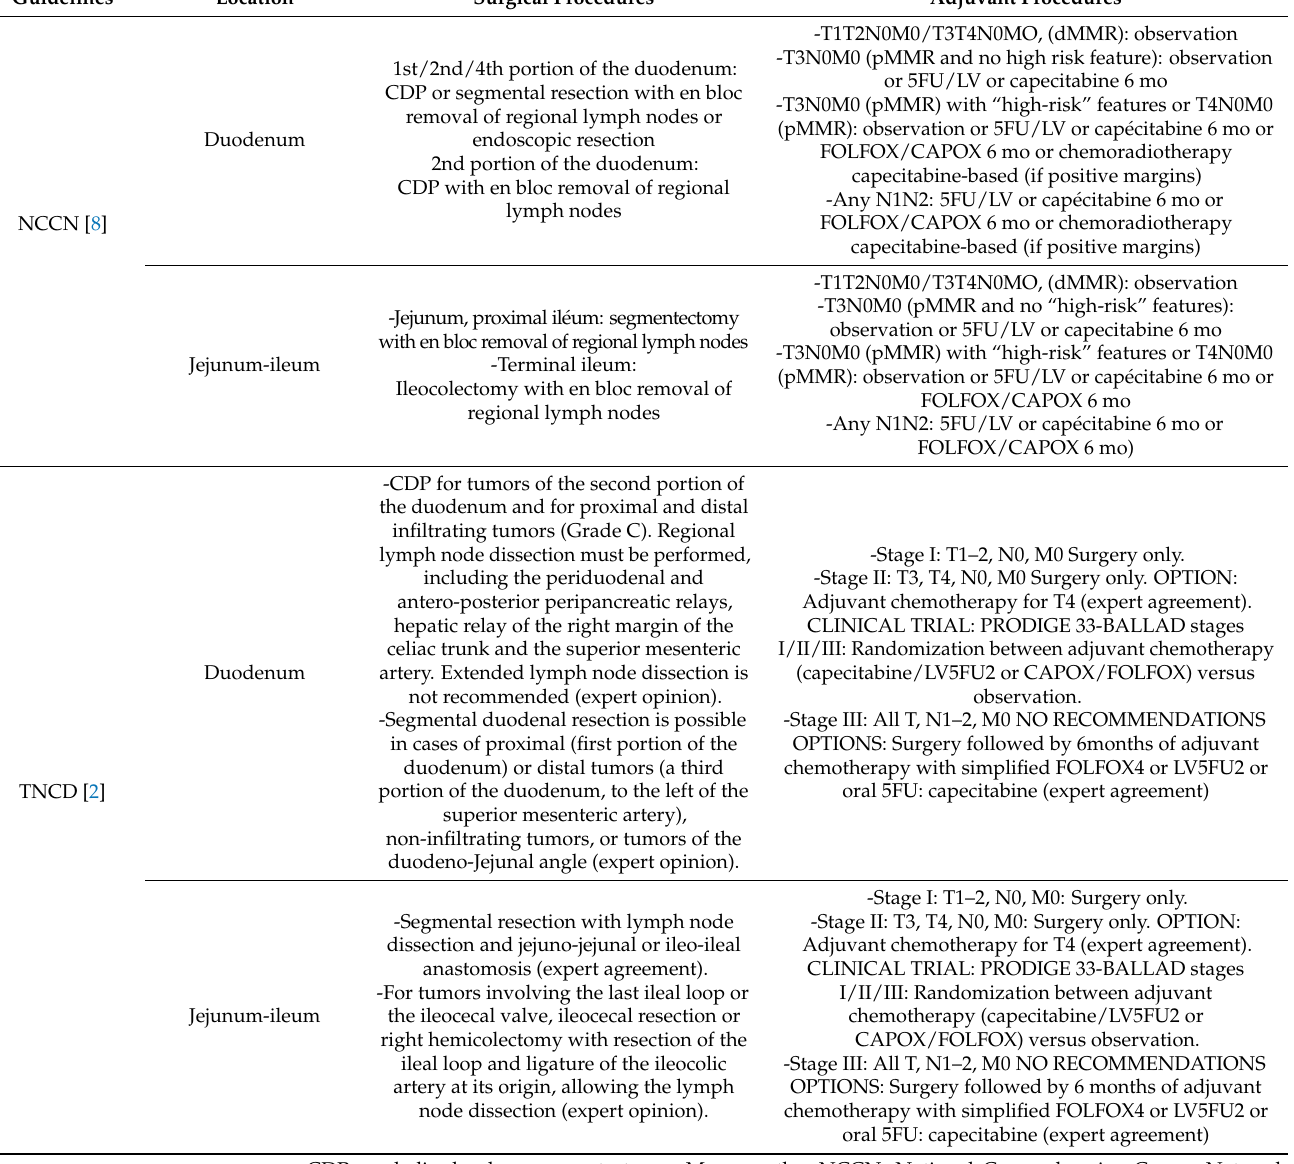
Table 4. Summary of international guidelines for localized small bowel adenocarcinoma surgical and adjuvant